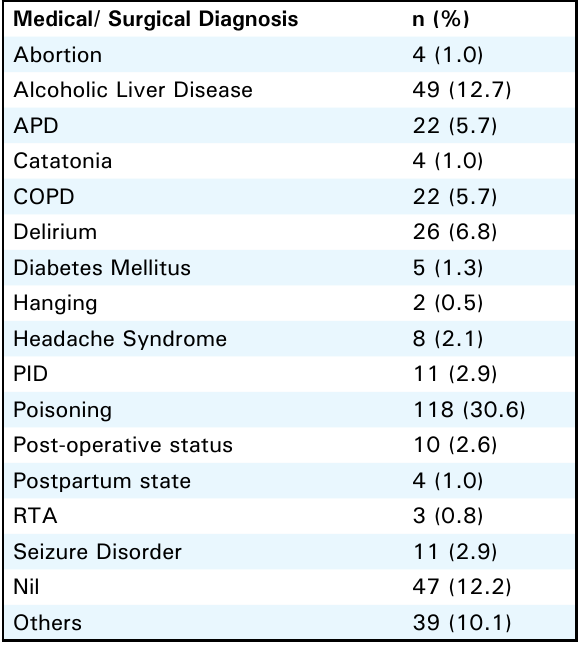
Table 4. Medical/ Surgical Diagnosis of the Patients evaluated.